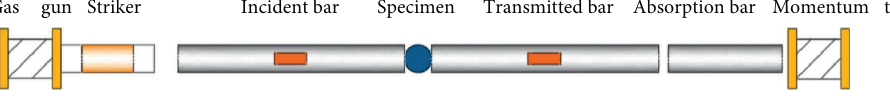
Figure 1: Schematic diagram of the SHPB test system.